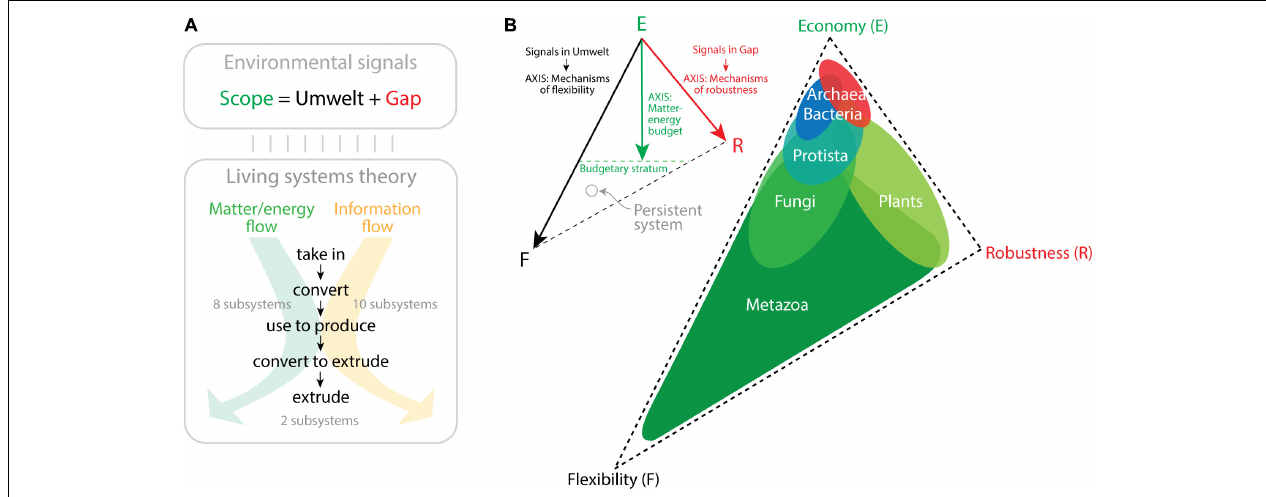
FIGURE 3 | The triangle of biological persistence. (A) An open biological system is exposed to a wide range of environmental signals (the system’s Scope), which are either perceived (Umwelt) or not (Gap). These signals establish matter–energy and information flows that are processed by 20 critical subsystems enabling a multitude of processes and functions (described in Miller, 1978). Two kinds of processes that are interconnected can be established, “ communication ” processes that transform information from one state into another, and “ action ” processes, which move matter–energy in space–time. Both processes function by taking in and finally extruding matter–energy and information after processing through intermediate stages. (B) The triangle of persistence describes the space of evolutionary trade-off solutions among economy , flexibility , and robustness. The triangle is bounded by the three engineering strategies, with economy measured as matter–energy budget, flexibility measured as the number of signals an organism processes in its Umwelt through flexibility mechanisms, and robustness measured as the number of signals in the Gap and the mechanisms that confer robustness to those signals. The three axes define the placement of persistent systems (e.g., organisms) in the trade-off space. The location of organisms belonging to the six kingdoms of life are suggested in the triangle of the right based on ecological and molecular information (Yafremava et al., 2013; Shahzad et al., 2015; Mainzer et al.,